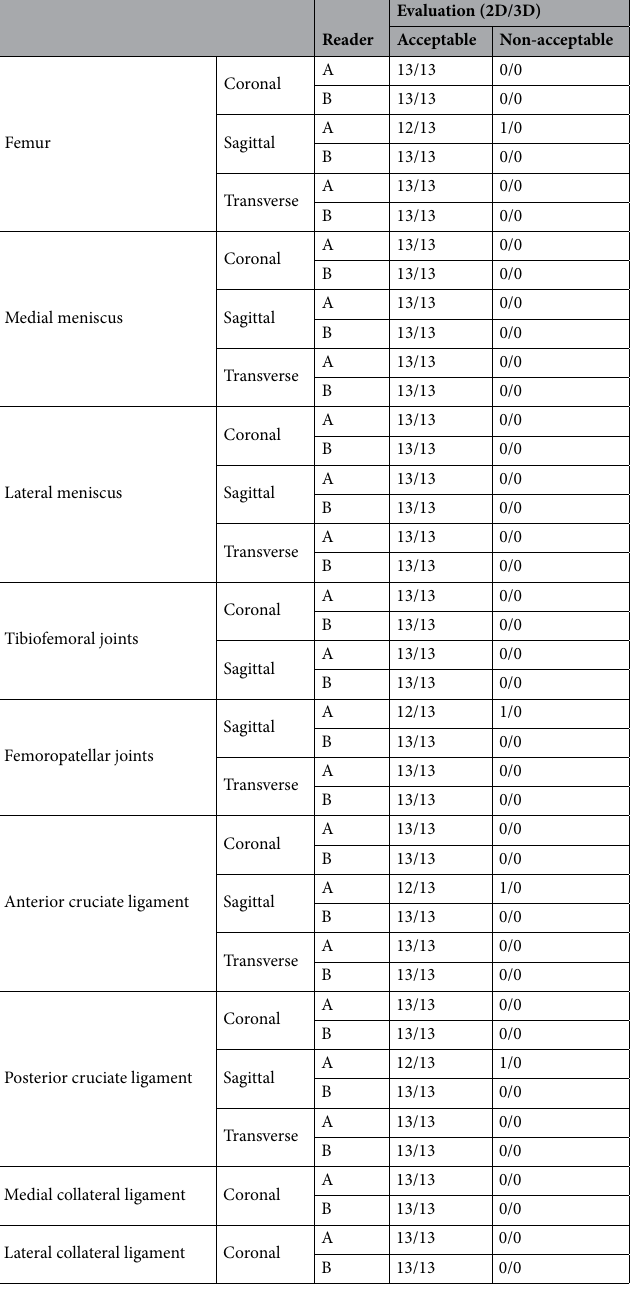
Table 3. Evaluation of anatomical structure visualization of thin-slice 2D FS-PDWI and 3D FS-PD MPV image by two readers. Acceptable, scores 3, 4 and 5; Non-acceptable, scores 1 and 2. Coronal and